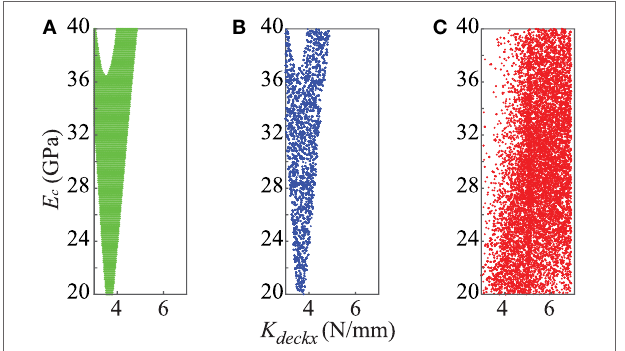
FIGURE 4 | Posterior PDF of primary model parameters as obtained using (A) EDMF, (B) modified BMU, and (C) traditional BMU.